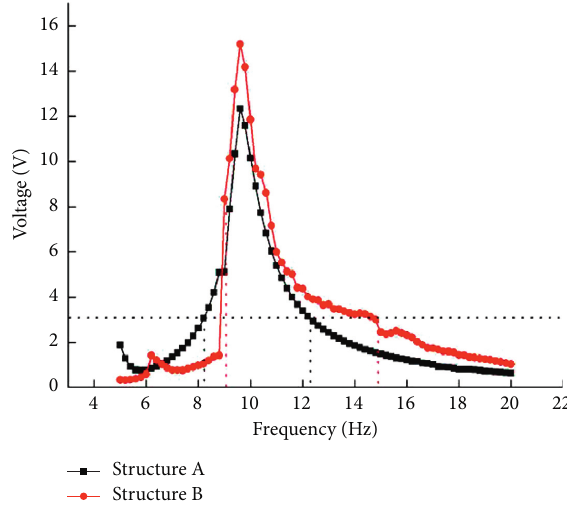
Figure 9: Relation of the frequency-voltage of the structure A and the structure B is given when the initial magnetic distance of the structure B is 14mm.